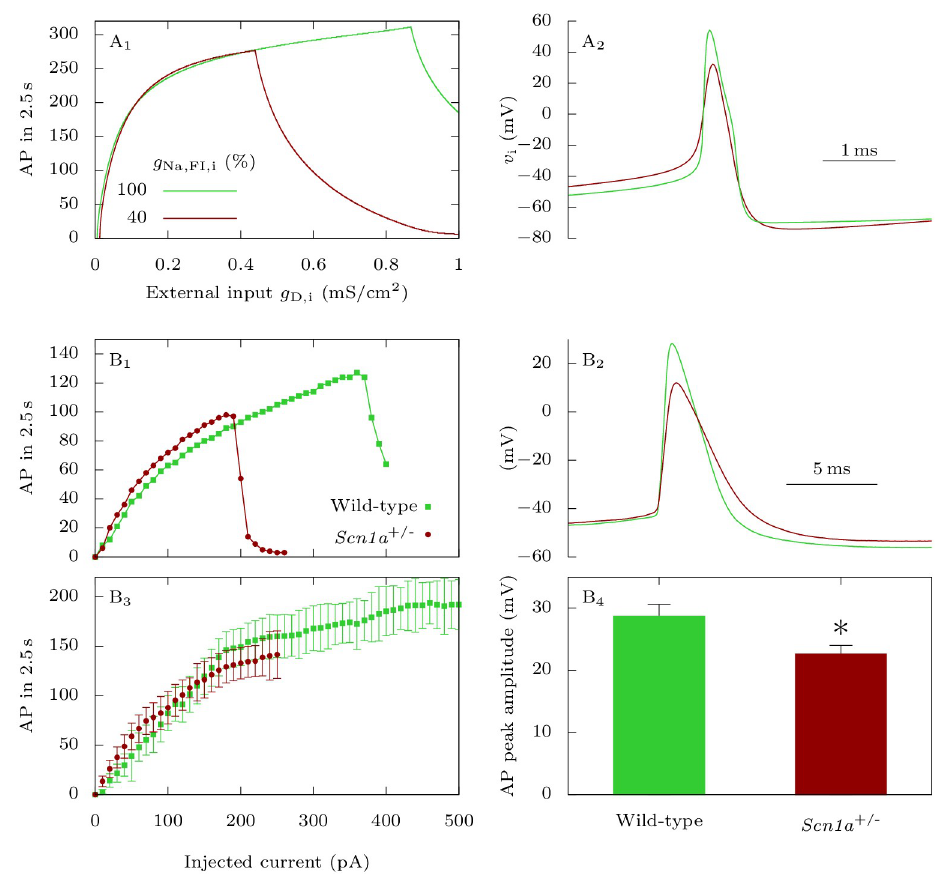
Fig 10. Effect of Na V 1.1 epileptogenic mutations on the firing of GABAergic neurons: Input-output relationship and action potential amplitude. A : Model simulations. We applied to the GABAergic neuron at rest 2.5 s long excitatory external inputs of conductances g D,i , for the default parameters (wild-type), or for a reduced sodium fast- inactivating maximal conductance g Na,FI,i (epileptogenic mutations). A 1 : Number of action potentials. A 2 : Representative action potentials, for g D,i = 0.3 mS � cm − 2 . B : Experimental data. B 1 : Representative fast spiking neurons recorded in cortical slices from Scn1a +/- mice and wild type littermates, selected for having similar input-output curves with lower injected current, showing that the Scn1a +/- neuron was more prone to depolarization block (sharp decrease of action potential number). B 2 : Comparison of the first suprathreshold action potential recorded in the neurons selected for panel B1. B 3 : Mean input-output relationships for fast spiking neurons recorded from Scn1a +/- ( n = 7) and wild type littermates ( n = 7), the number of elicited action potentials was not different, but depolarization block was induced with lower depolarizing current (the traces in which there was depolarization block were excluded, to avoid the influence of depolarization block in the evaluation of the number of action potentials elicited with larger depolarizing currents). B 4 : Mean peak amplitude (absolute value) of the first suprathreshold action potential for fast spiking neurons recorded from Scn1a +/- (22.6 ± 1.5 mV, n = 7) and wild type littermates (28.7 ± 2.0 mV, n = 7); p = 0.044 Mann-Whitney test. � p <